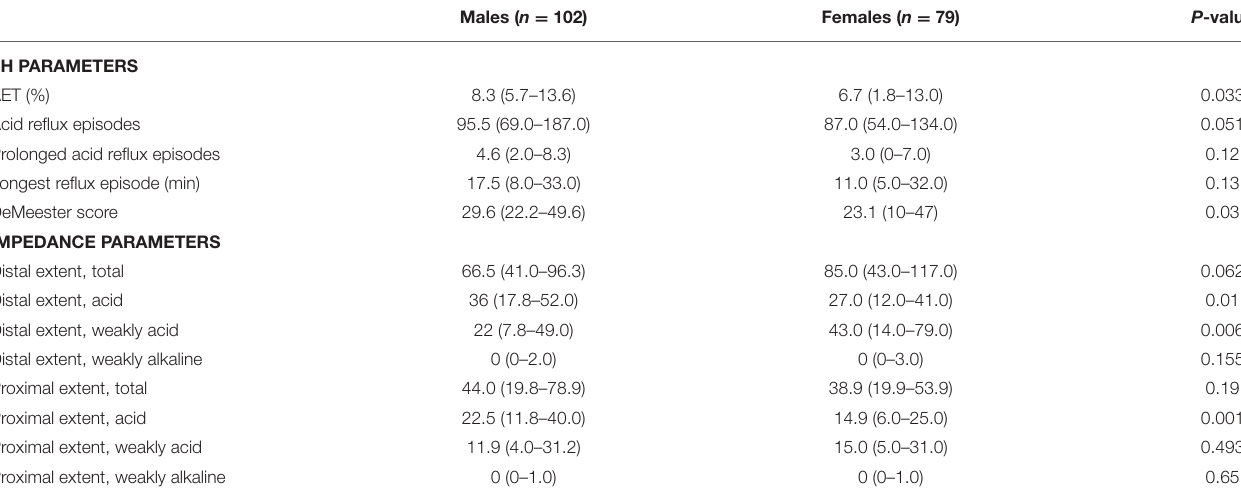
TABLE 2 | Reflux characteristics according to sex.